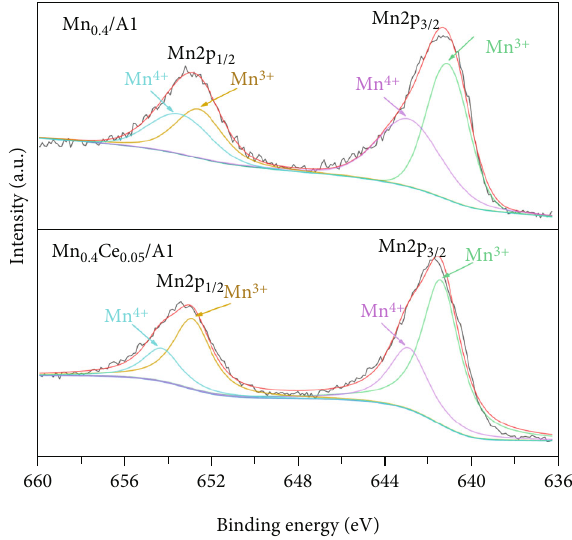
Figure 4: XPS spectra for Mn 2p of (a) Mn Mn Ce 0.4 0.05